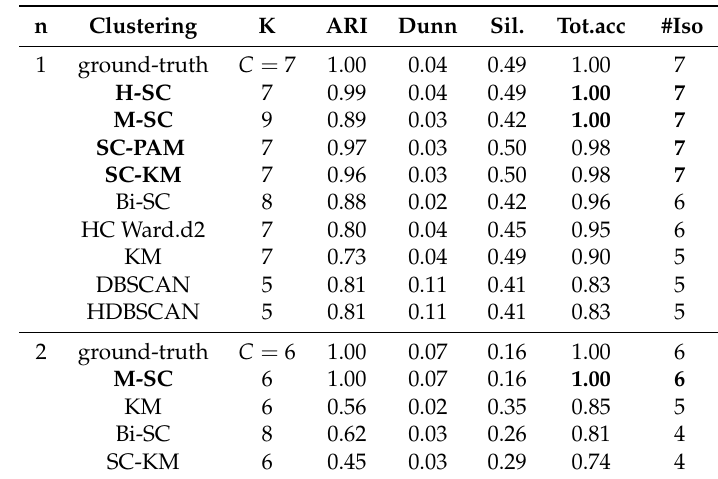
Table 2. Clustering approaches applied to pattern discovery, ordered by well-isolated pattern numbers (#Iso) with performance indicators: Adjusted Rand Index (ARI), Dunn and Silhouette (Sil.) indexes, total accuracy (Tot.acc) and the number of clusters K . Bold: #Iso = C . 0.00: non zero number (value with more 3 decimal). n is the dataset number. Only methods that succeed in #Iso > 50% were